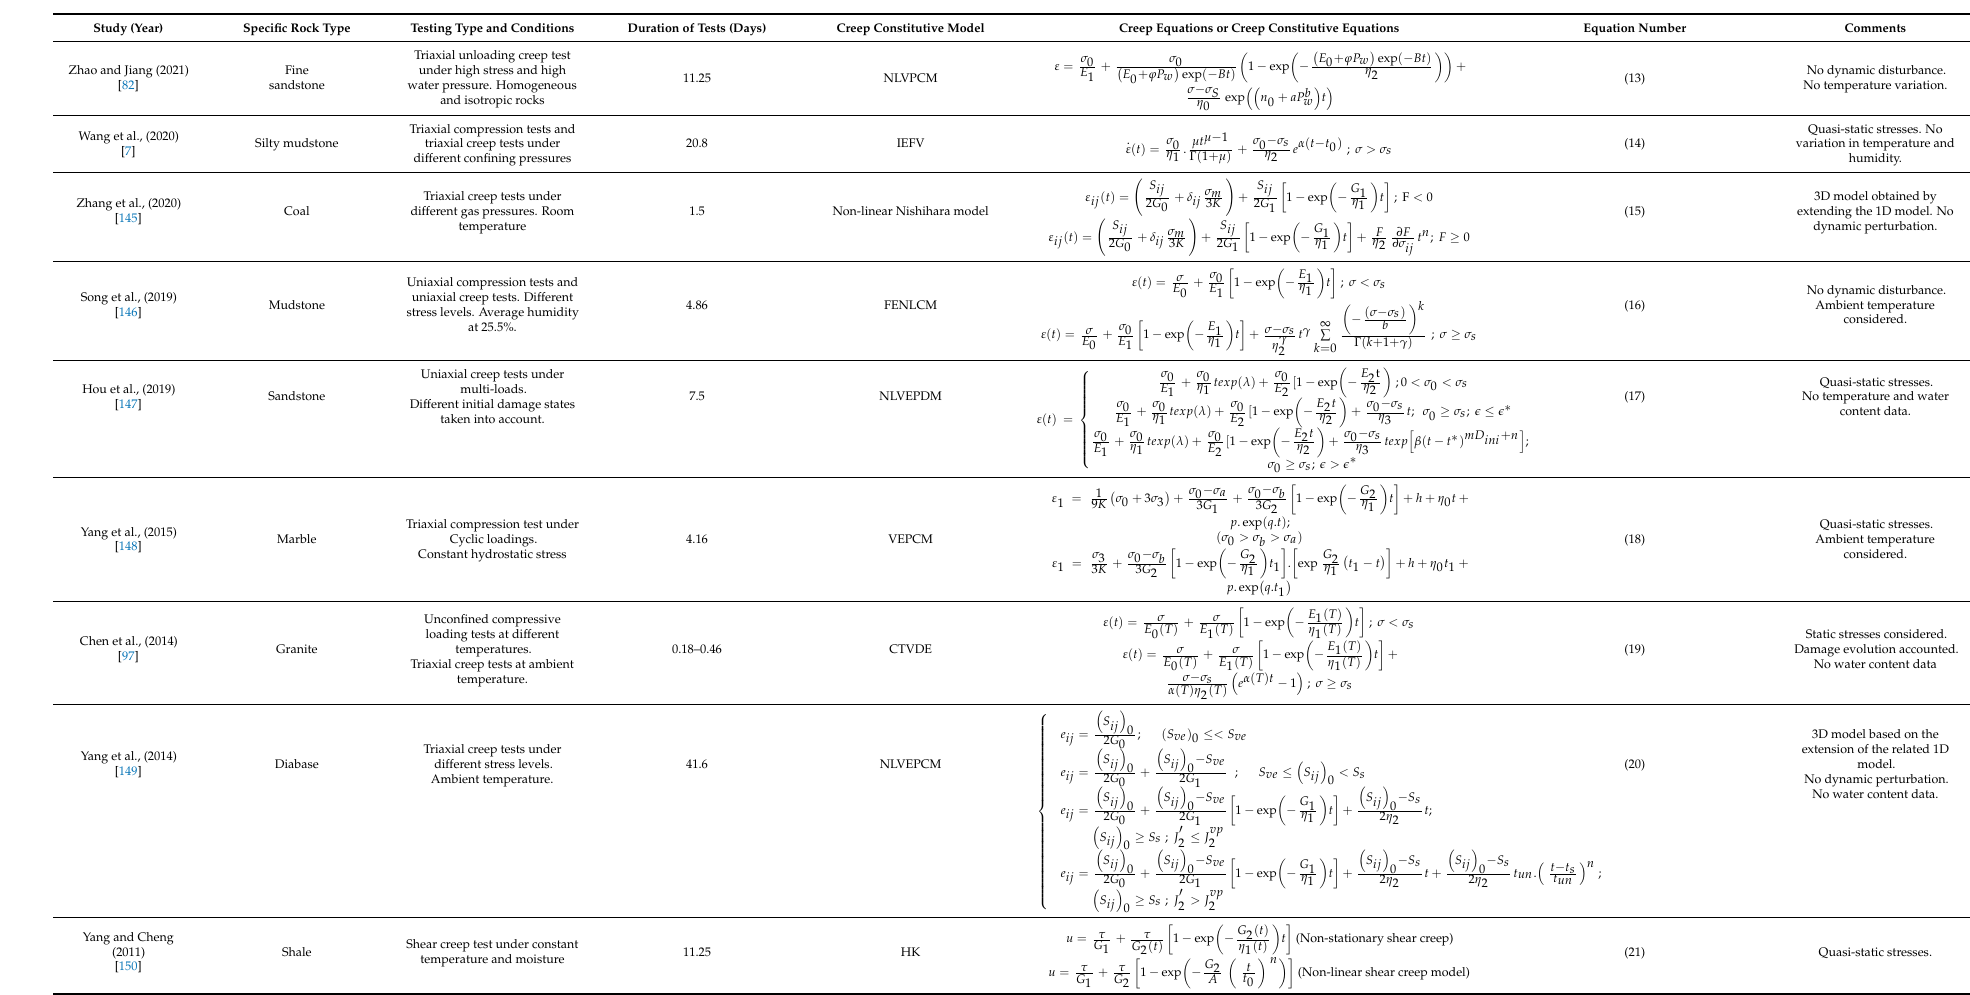
Table 4. Summary of relevant details of creep constitutive models for various specific rock